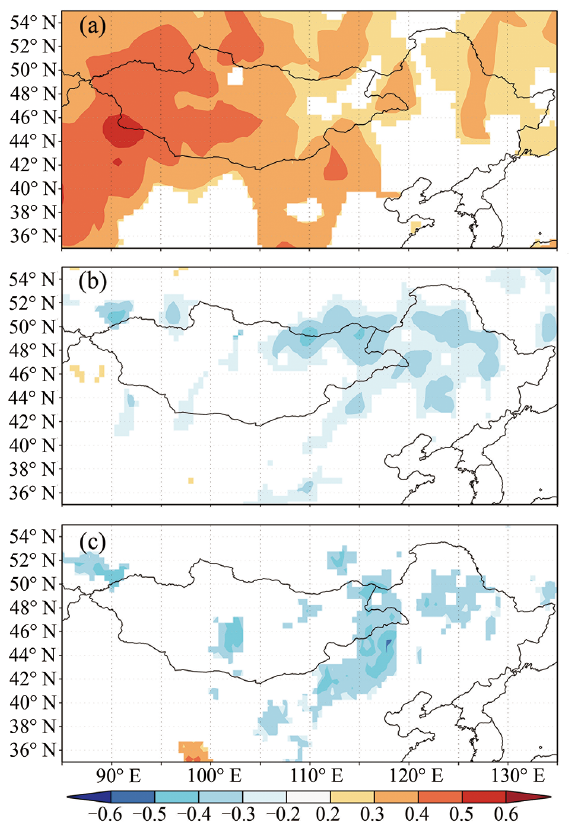
Figure 9. Spatial correlations between the annual east Asian mon- soon index and the local (a) temperature, (b) precipitation and (c) scPDSI from 1948 to